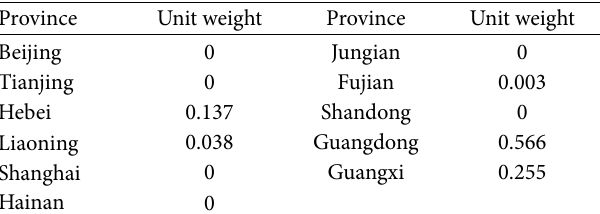
Table 2: The weights of the control group.